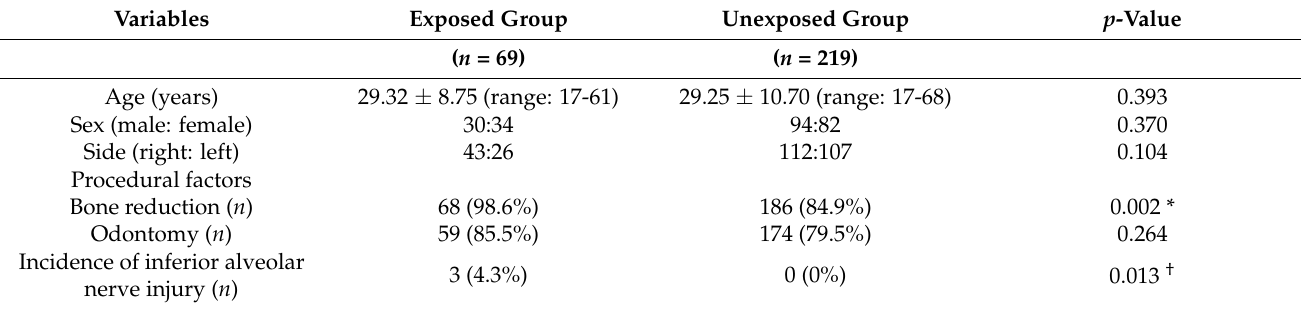
Figure 1. Flowchart showing the process of case selection. M3, mandibular third molar; IAN, inferior alveolar nerve. Table 1. Comparison of Baseline Characteristics and Incidence of Inferior Alveolar Nerve Injury between the Exposed Group and the Unexposed